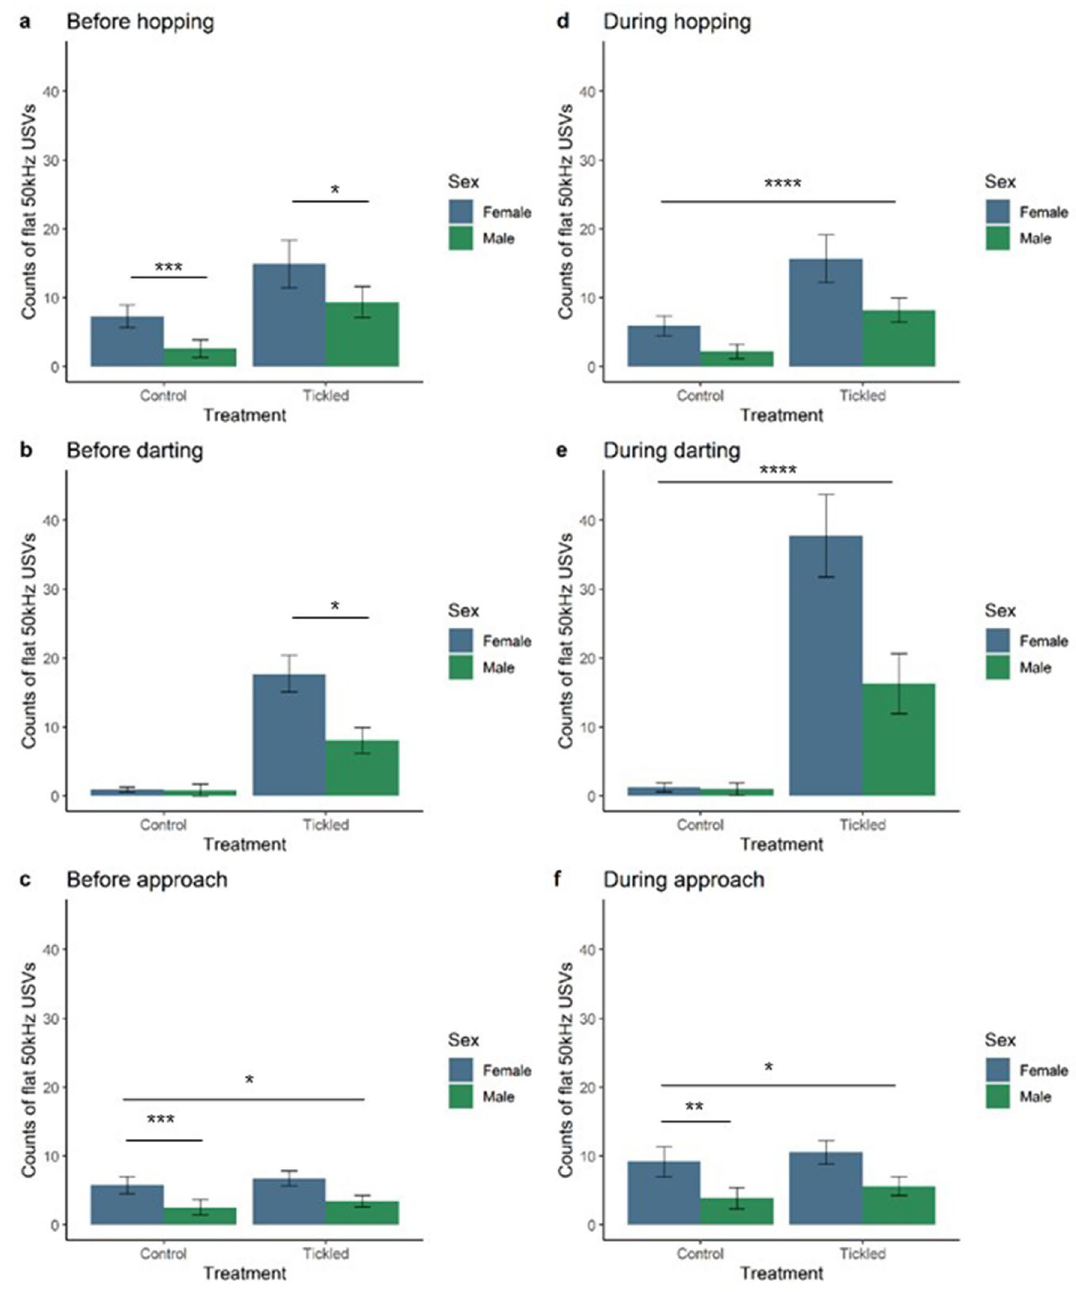
Figure 1. Flat ultrasonic vocalisations (USVs) paired with play-related behaviours in tickled compared to control rats. Estimated marginal means ± 95% CI of flat 50 kHz USVs produced in the one second before hopping ( a ), darting ( b ) and approach to the hand ( c ) ‘play-related’ behaviours, and flat 50 kHz USVs produced during hopping ( d ), darting ( e ) and approach to the hand ( f ) ‘play-related’ behaviours. Female (blue) and male rats (green). n = 16/group. *denotes p ≤ 0.05; **denotes p ≤ 0.01; *** denotes p ≤ 0.001; **** denotes p ≤ 0.0001 for significant pairwise